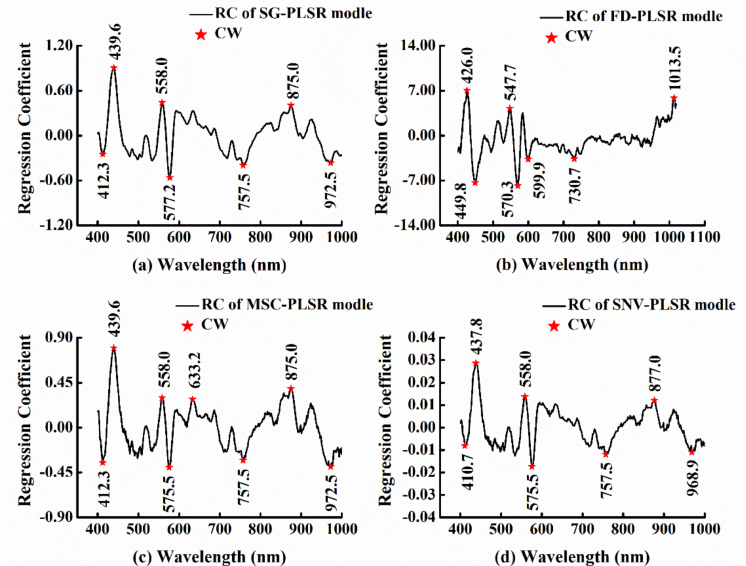
Figure 5. CWs of the belly region selected by the method of RC based on di ff erent preprocessed methods ( a ) SG-FD, ( b ) FD, ( c ) MSC, and ( d )